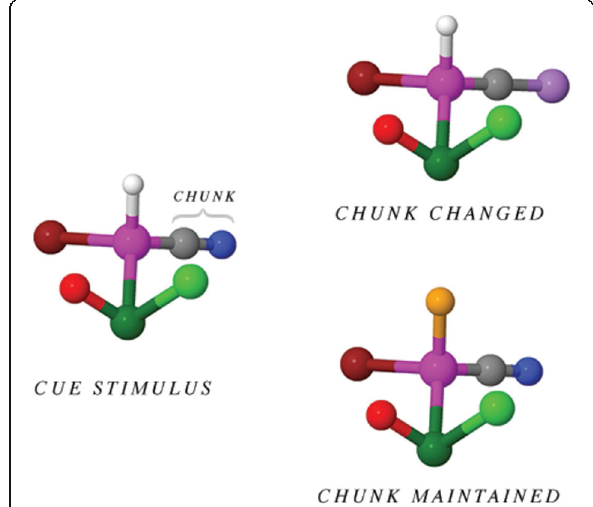
Fig. 4 Examples of cue stimulus, chunk-changed stimulus, and chunk-maintained stimulus (all 2D) used in Study 1. Note that the relevant chunk in this example is the gray atom (carbon) and blue atom (nitrogen) indicated in the cue